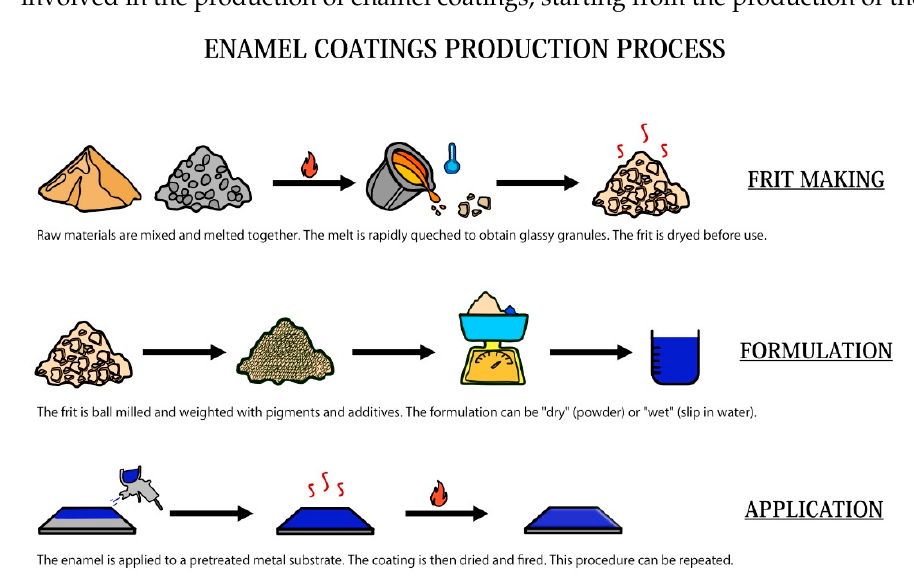
Figure 2. Schematic representation of the enamel production process.